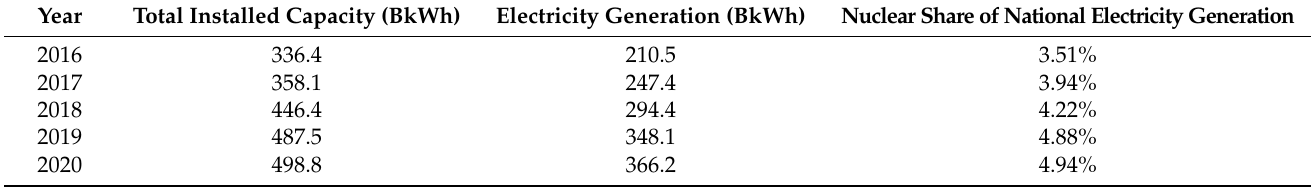
Table 1. Comparisons of commercial nuclear power, total installed capacity, electricity generation and its share in national electricity from 2016 to 2020 in China.